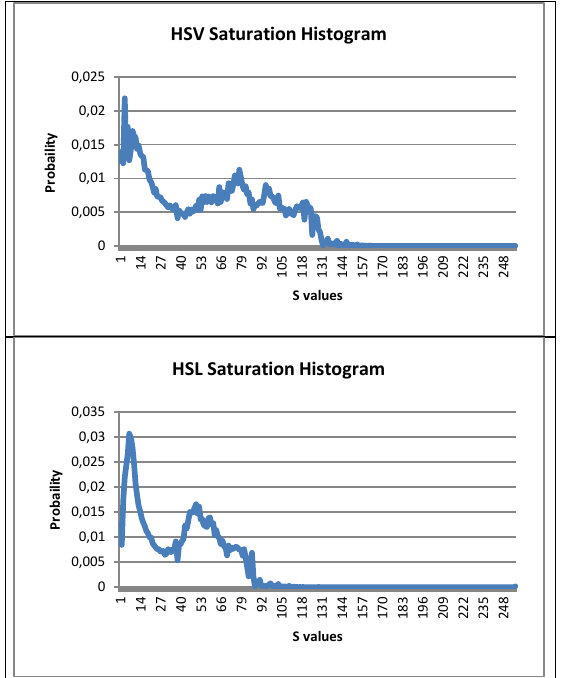
Table 1. Saturation Histograms from HSV and HSL color models Sky image segments (Table 2) and cloud image segments (Table